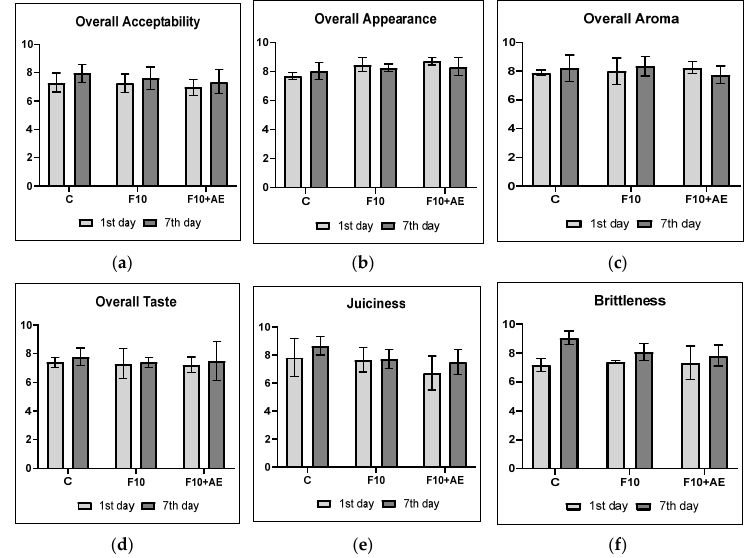
Figure 2. The results of sensory evaluation of breast meat samples (means ± SD): ( a ) overall acceptability, ( b ) overall appearance, ( c ) overall aroma, ( d ) overall taste, ( e ) juiciness and ( f ) brittleness. C: control group; FF10: broilers fed with a diet enriched with supplementation of 10% FF; FF10 + AE: broilers fed with a diet enriched with 10% supplementation of FF supported with 0.2% agrimony extract.